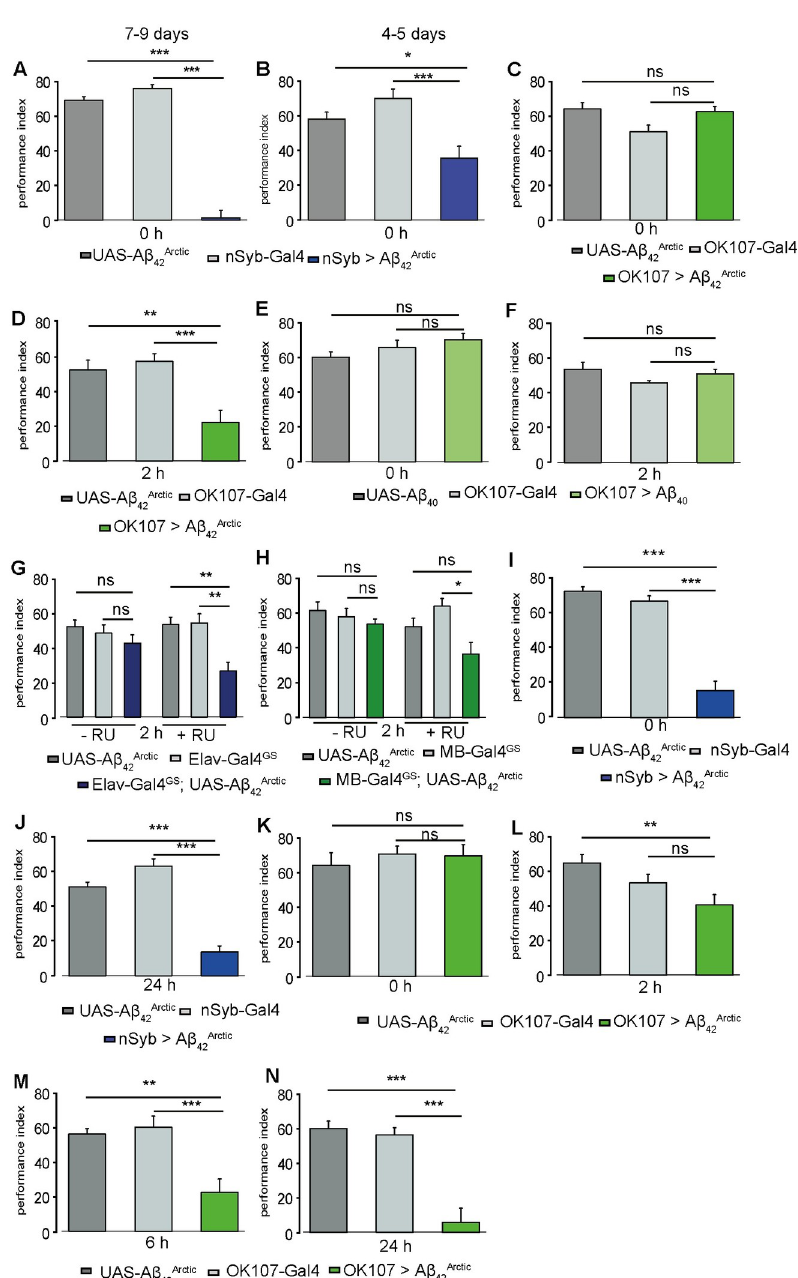
Fig 1. Expression of amyloid β peptides in the brain or MBs leads to memory defects in aversive and appetitive conditioning. (A-H) Aversive olfactory conditioning experiments were conducted with A β 42Arctic expressing flies. (A, B) Pan-neuronal expression of A β 42Arctic impaired memory measured immediately (0 h) after training in 7- to 9-day- old flies (A) 4- to 5-day-old nSyb > A β 42Arctic flies (B), n � 12. (C, D) Flies expressing A β 42Arctic in the MB using Ok107-Gal4 did not perform differently from parental controls for 0-h memory (C; n � 12) but showed a significantly lower 2-h memory performance (D; n � 12). (E, F) Flies expressing the nontoxic A β in the MB have no significant 40 memory impairment 0 h (E) or 2 h (F) after conditioning (n � 12). (G, H) The GeneSwitch Gal4 system was used to restrict the expression of A β 42Arctic to the adult stage, by feeding flies RU486 after the hatching for 8 days until the conditioning experiments. (G) elav - Gal4 GS ; A β 42Arctic flies fed with RU486 showed a lower performance index than vehicle-treated flies 2 h after training (n � 12). (H) Induction of A β 42Arctic expression after hatching in MB cells using MB - Gal4 GS resulted in a slightly reduced 2-h memory performance (n � 12). (I-N) Appetitive olfactory conditioning experiments were performed with flies expressing A β 42Arctic in the brain or specifically in the MB. (I, J) Expression of A β 42Arctic in the whole brain impaired memory measured immediately (I; n � 12) and 24 h after conditioning (J;